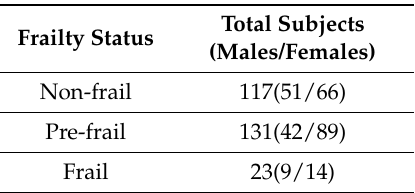
Table 2. Frailty status of